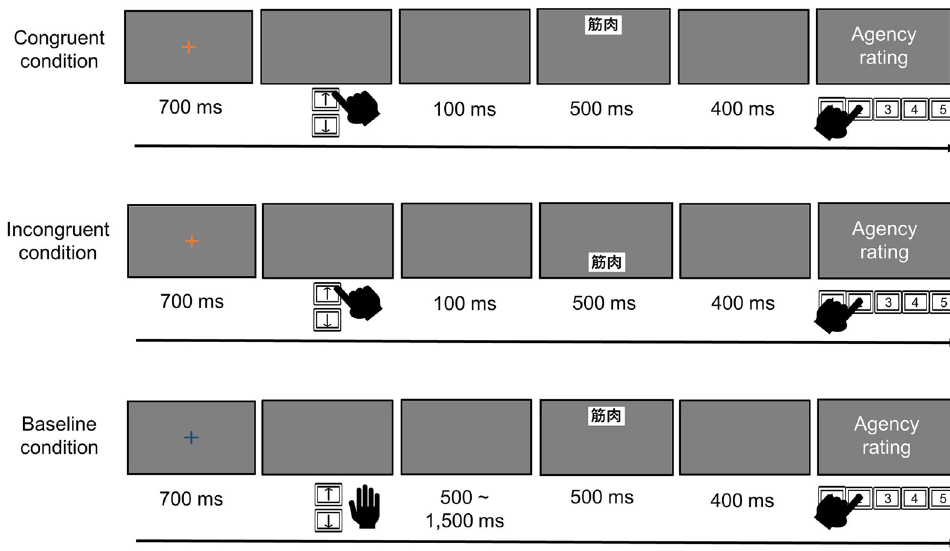
Figure 4. Schematic illustration of the agency task in Experiment